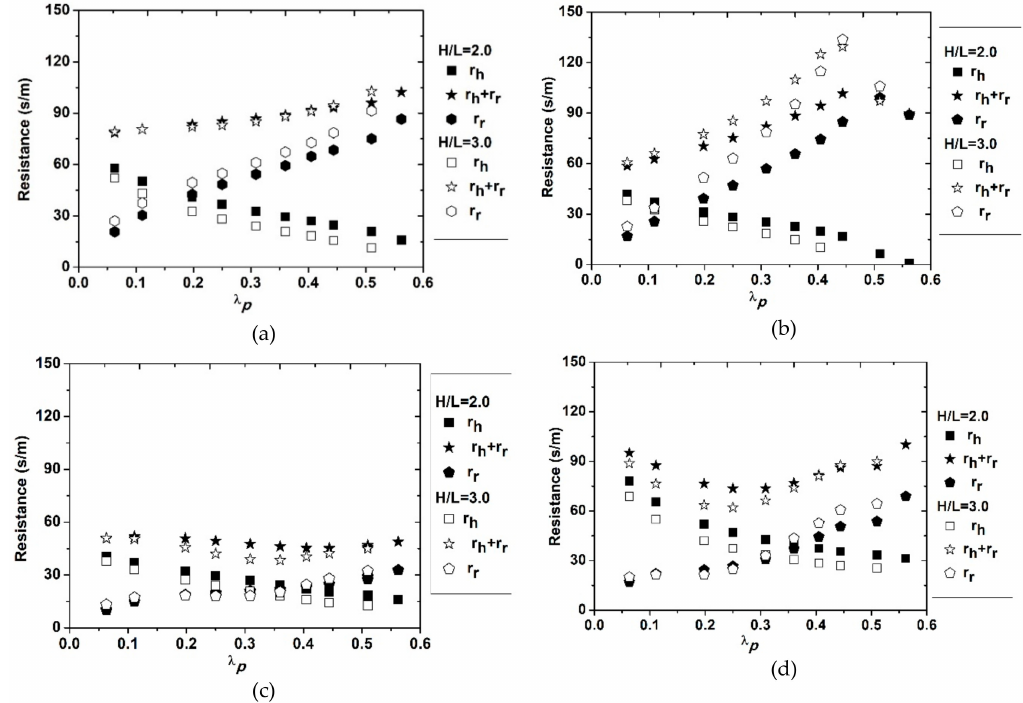
Figure 3. Resistances ( r h , r h + r a , r a , r h + r r , r r in Equations (2)–(4)) as a function of λ p for di ff erent seasonal conditions: ( a ) 11 April 2010; ( b ) 29 August 2010; ( c ) 28 October 2010; ( d ) 17 December 2010. H / L is the building height to width ratio. All buildings had square